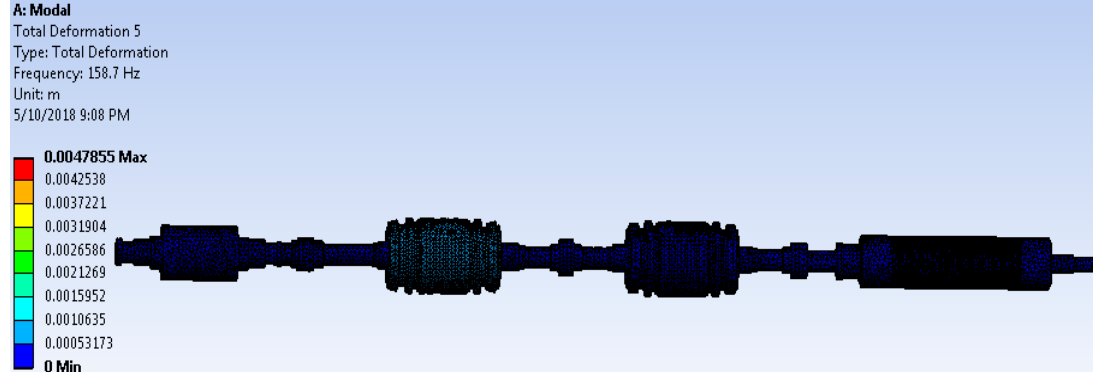
Figure 17. Concept 2 Mode 5 torsional natural frequency and deformation.